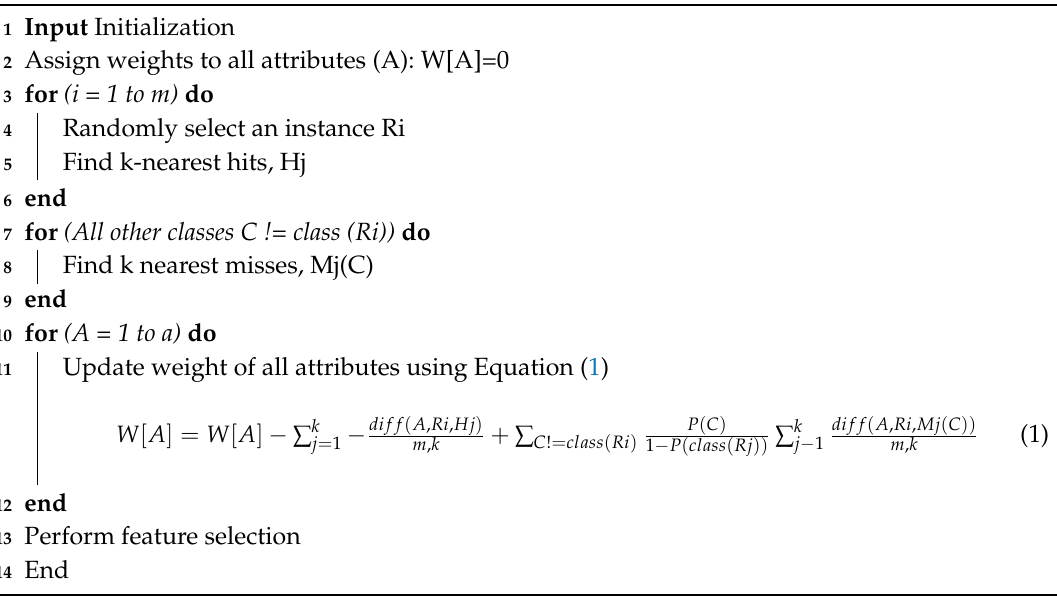
Algorithm 2: Pseudocode of